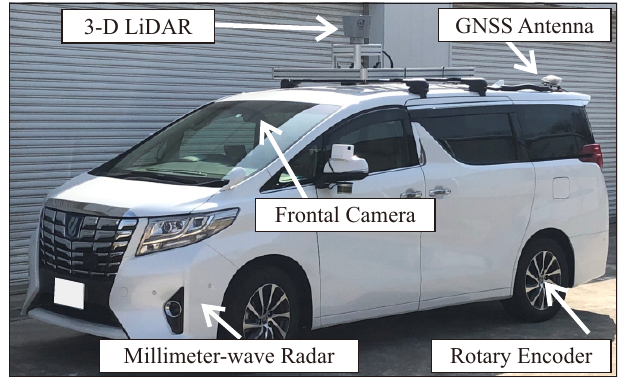
Figure 11. Experimental